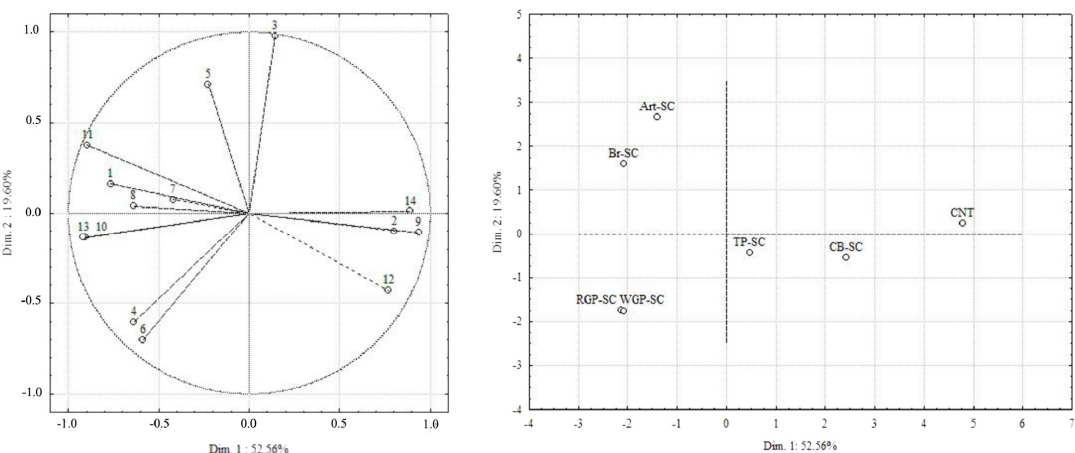
Figure 2. Principal components analysis of the sensory attributes of cheese (sample plot: right , variable plot: left ). CNT: control spreadable cheese; CB-SC: corn bran spreadable cheese; Br-SC: broccoli spreadable cheese; WGP-SC: white grape pomace spreadable cheese; RGP-SC: red